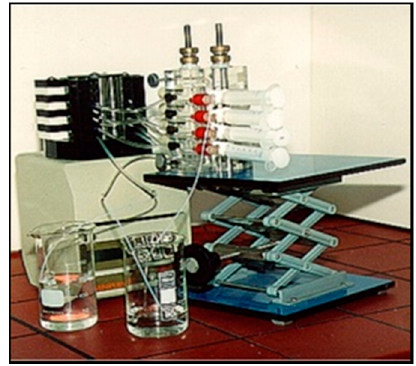
Figure 2. Filtration apparatus.